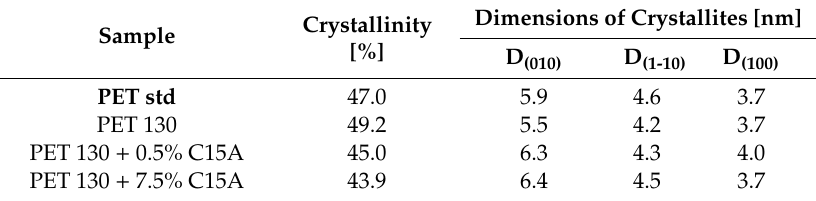
Table 2. Crystallinity and dimensions of crystallites obtained by means of WAXS method.